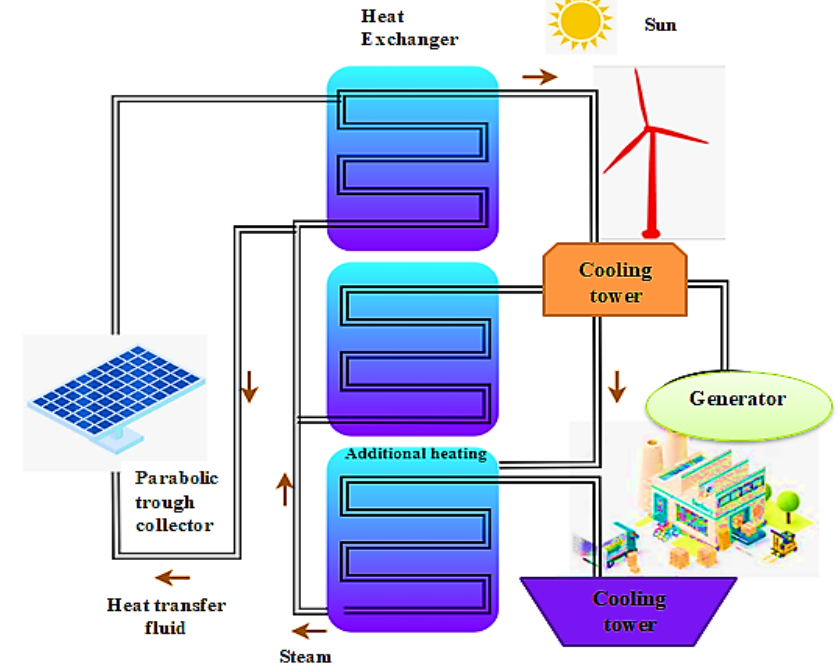
Figure 3. Solar thermal energy-based Figure 3 . Solar thermal energy-based electricity.